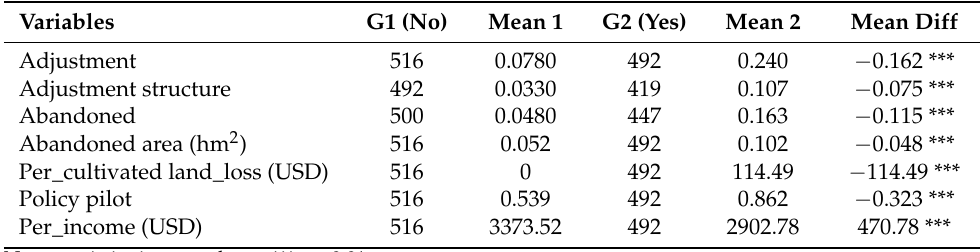
Table 2. Group mean t test of cultivated land use behaviour, loss to cultivated land by HWC and household income characteristics without “HWC” experience and with “HWC”